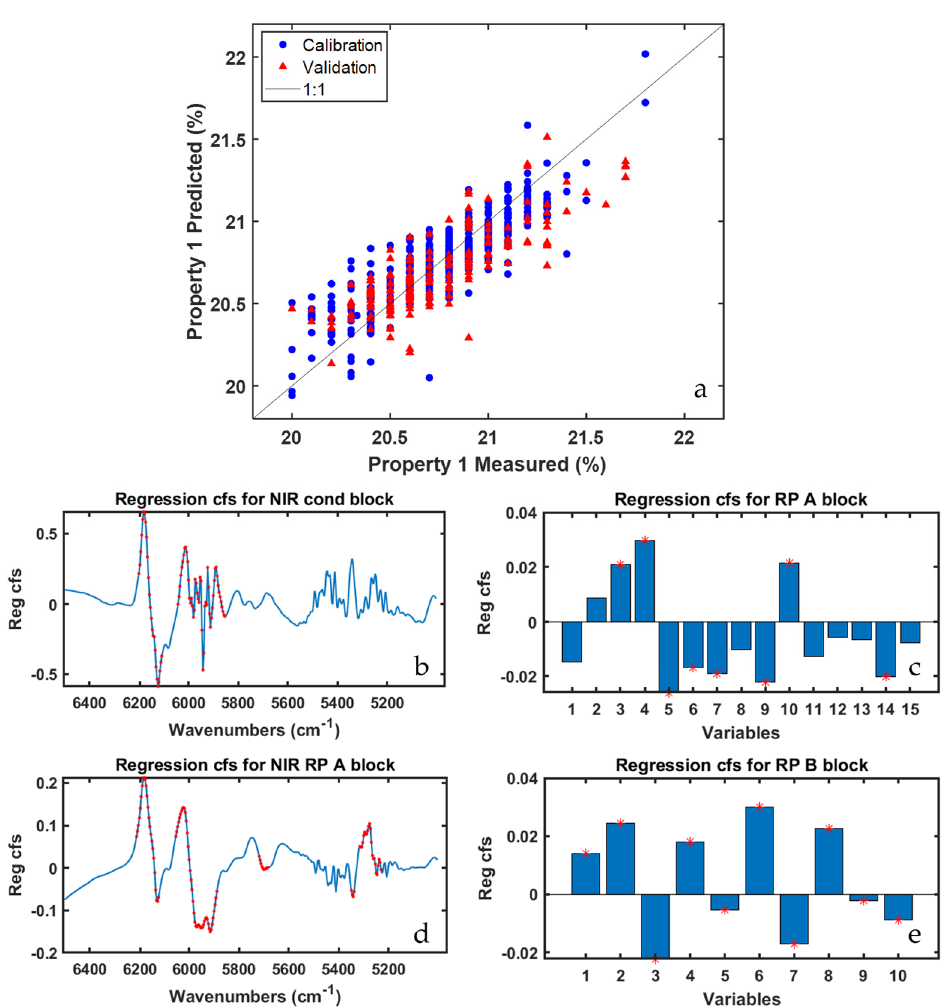
Figure 4. ROSA results for Property 1 prediction (‘ROSA no cut zone’ model). Predicted vs. measured value plot ( a ); regression coefficient for NIR cond ( b ); RP A ( c ); NIR RP A ( d ); and RP B ( e ) data blocks. Red stars indicate variables having VIP scores higher than one.